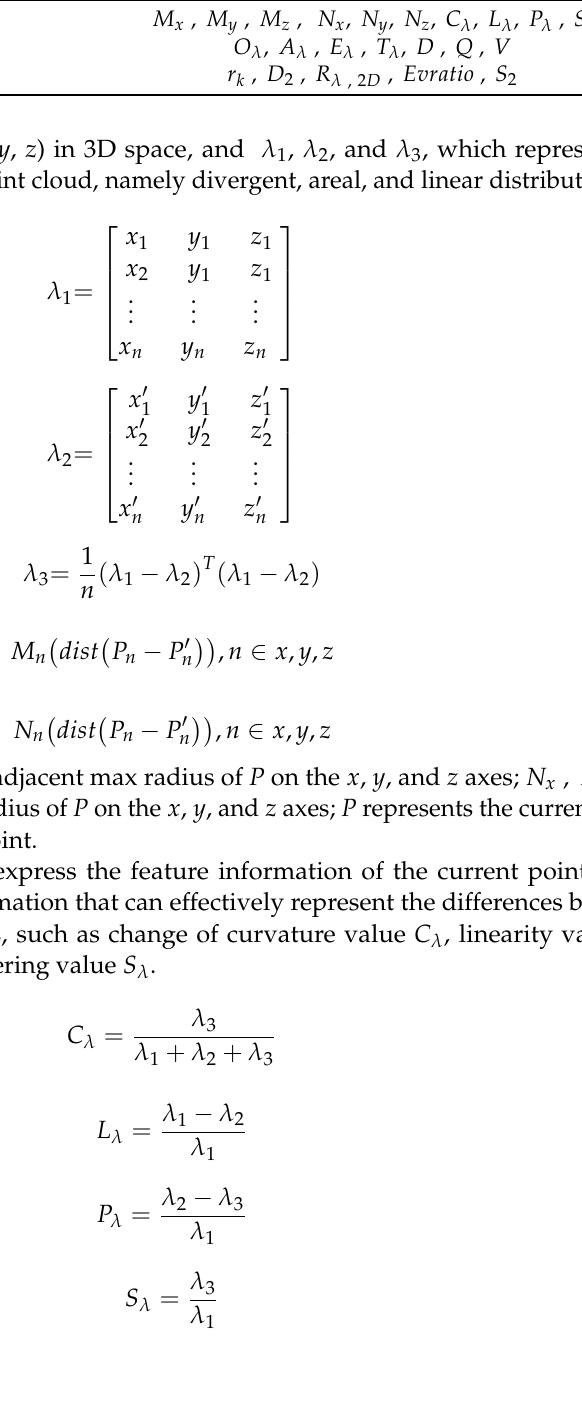
Table 1. Point cloud feature values. Type